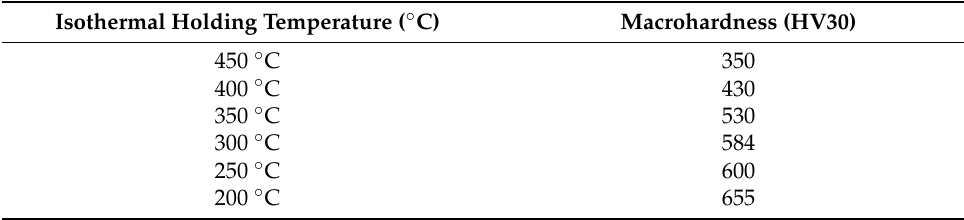
Table 3. Macrohardness measurements (HV30) of Q&B and Q&P